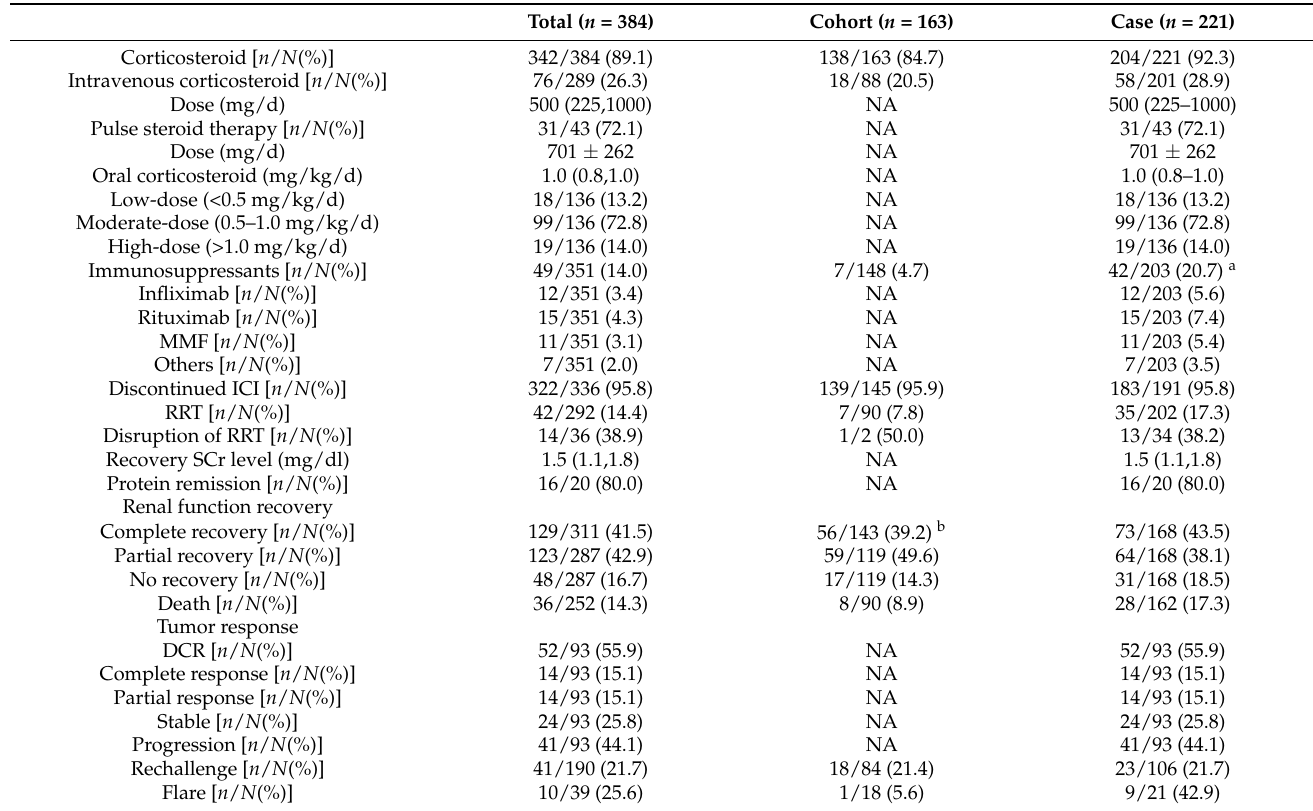
Table 3. Treatment and outcome of total patients with biopsy-proven kidney IRAEs.